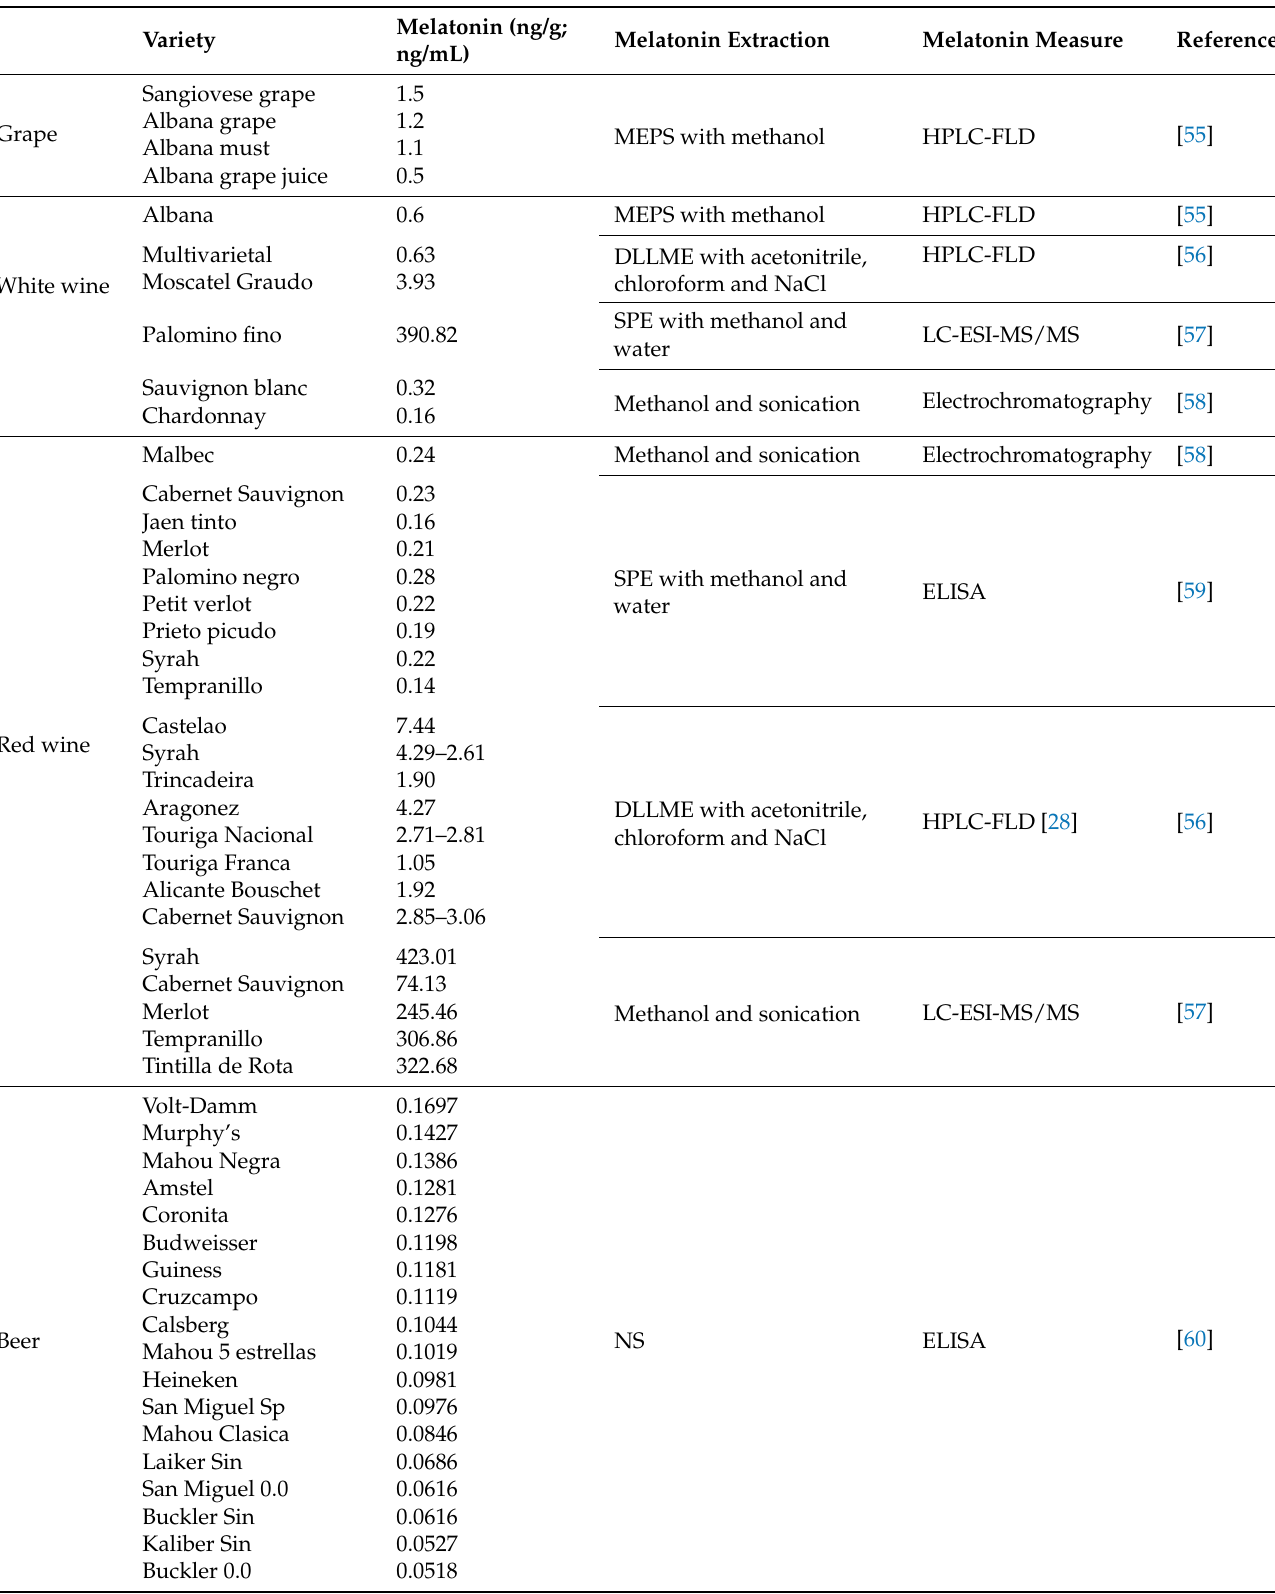
Table 1. Melatonin content in grapes, wine, beer, and oils of the